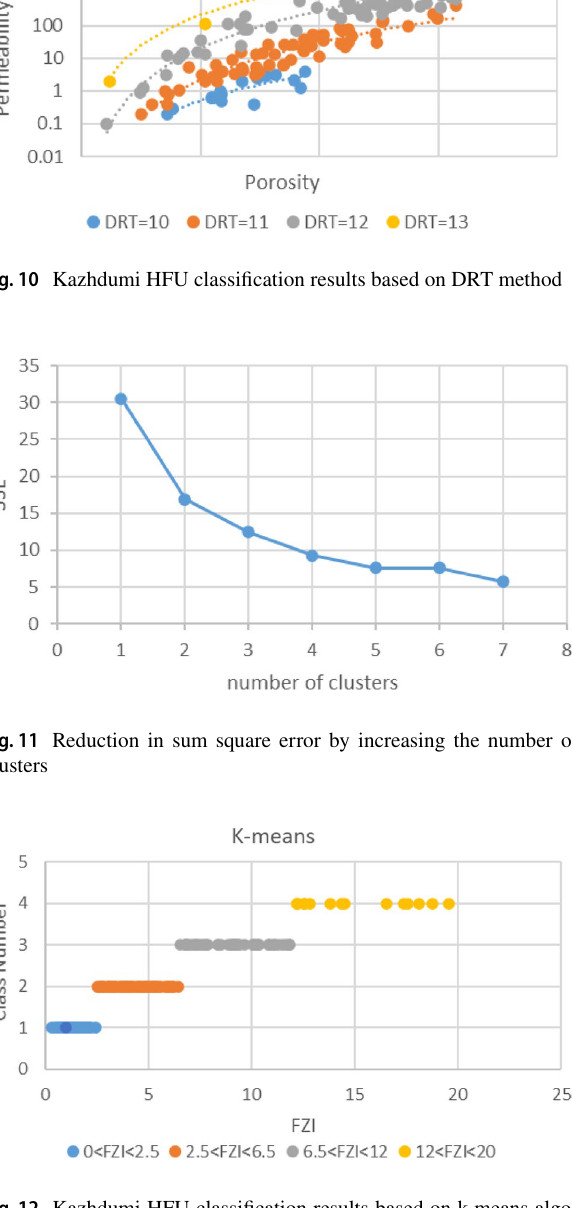
Fig. 12 Kazhdumi HFU classification results based on k-means algo-